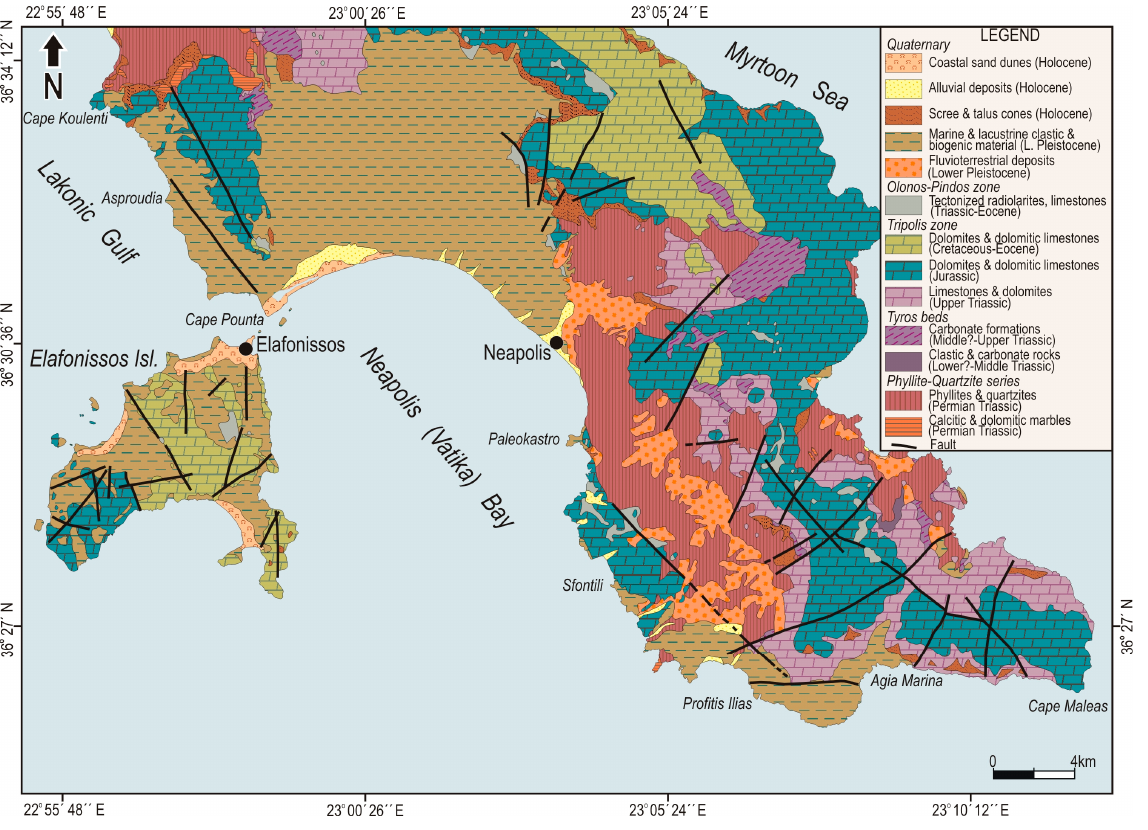
Figure 2. Geological map of the study area modified from Theodoropoulos [51], IGME [68], and Lekkas et al. [69]. Fault kinematics are undifferentiated, and most faults are inactive.